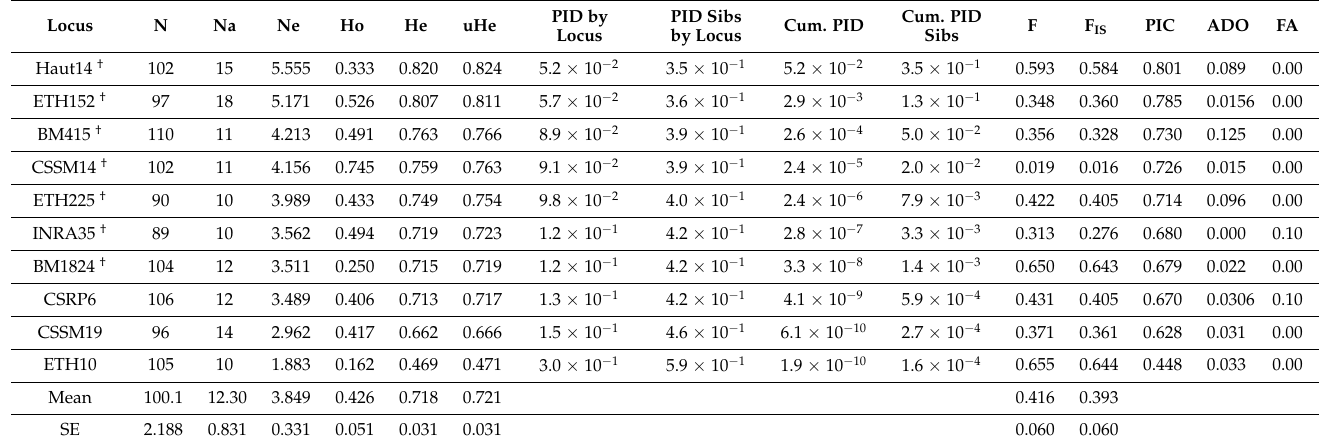
Table 1. Population genetic indices for the Himalayan ibex in the Indian trans-Himalayan region.